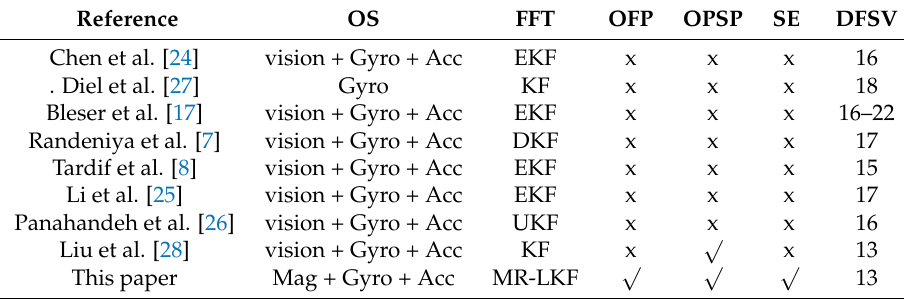
Table 1. Related work on inertial-visual fusion (OS, FFT, OFP, OPSP, SE, DFSV, KF, DKF, EKF, UKF, Gyro, Mag and Acc stand for Orientation Source, Fusion Filter Type, Orientation-aided Feature points, Orientation and Position in the Same Process, Scale Estimation, Dimension of Filter’s State Vector, Kalman Filter, Decentralized Kalman Filter, Extended Kalman Filter, Unscented Kalman Filter, √ Gyroscope, Magnetometer and Accelerometer respectively; x—No and